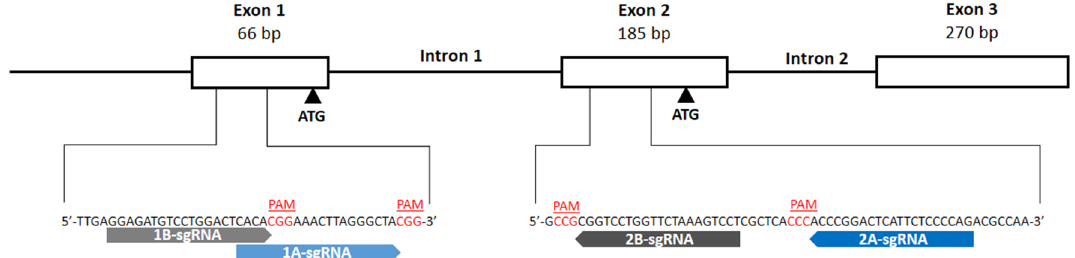
Figure 1. Schematic representation of the first 3 exons of HLA-G gene and the 4 designed sgRNAs. The white boxes and lines represent exons and introns, respectively. The sequence below represents part of exon 1 and 2 containing Cas9/sgRNA target sites for 1A-, 1B-, 2A- and 2B-sgRNAs. Protospacer-adjacent motif (PAM) is labeled in red. Black arrows represent the two transcription start